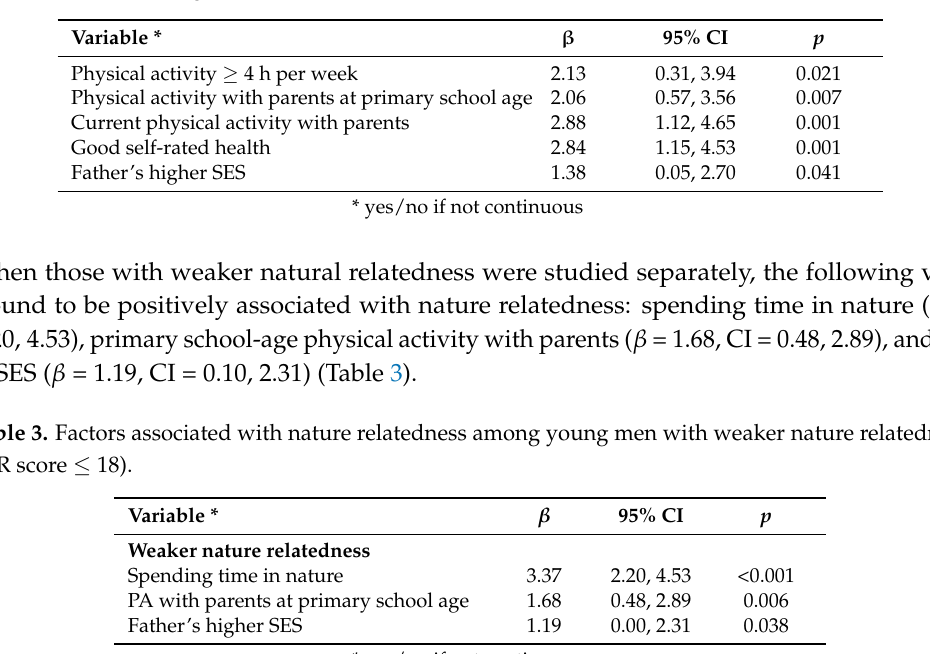
Table 2. Factors associated with nature relatedness among young men ( n = 914) according to multivariable linear regression.